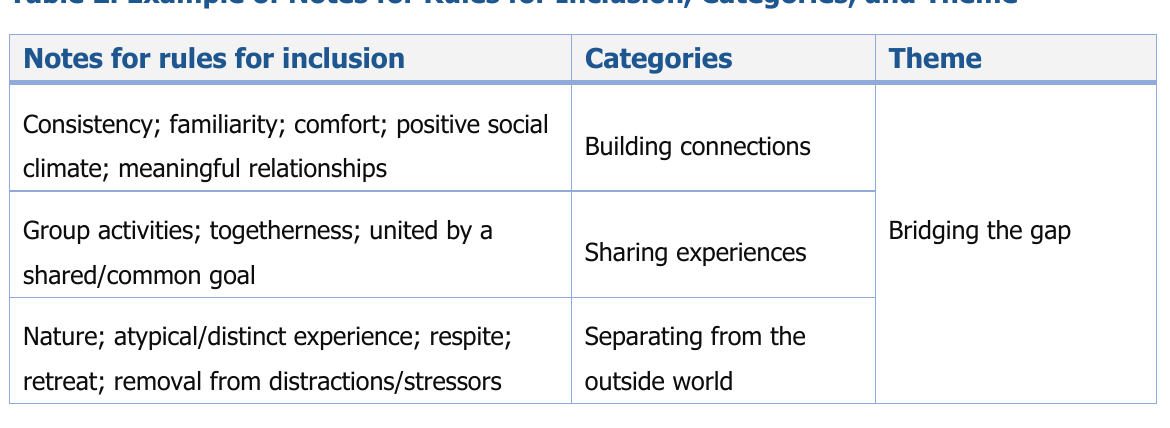
Table 2. Example of Notes for Rules for Inclusion, Categories, and